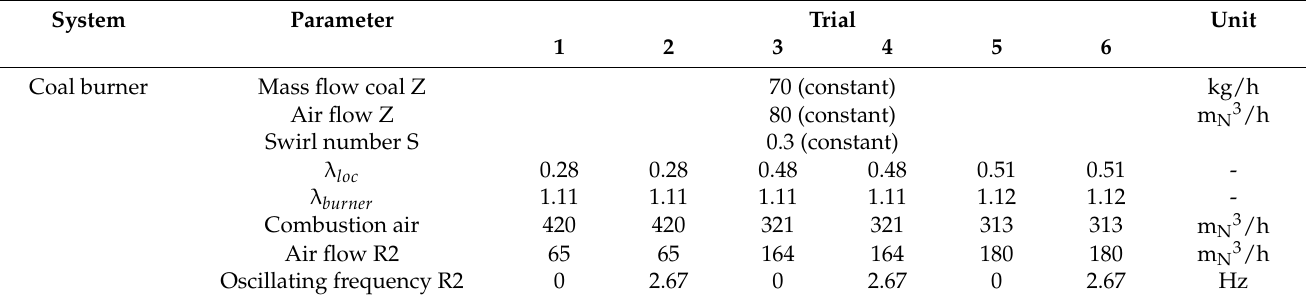
Table 3. Trial plan Campaign B investigation of